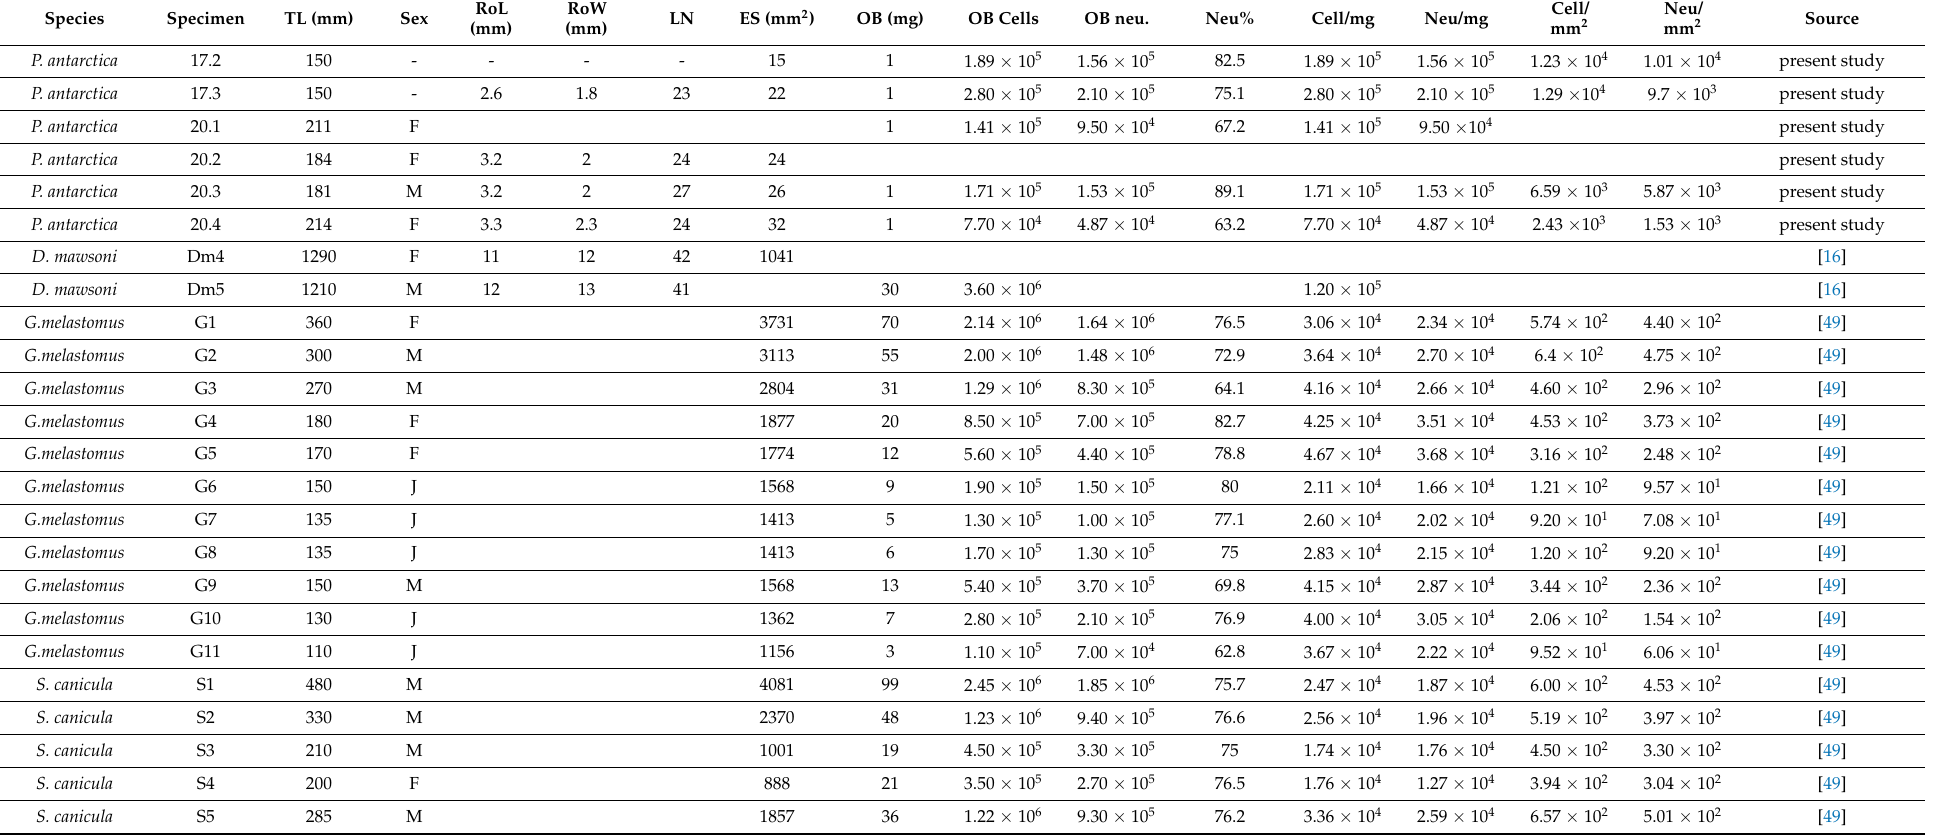
Table 2. Measurements and counts for 4 species of fish from the present study and the literature. TL = the total length was measured for fresh fish for all the specimens but P. antarcticum specimens, where it was calculated on the basis of paraformaldehyde-fixed and ethanol 70%-preserved brains (See Materials and Methods). RoL = Rosette Length; RoW = Rosette Width; LN = lamellar number for one rosette; ES = epithelial surface area for one rosette; OB = mass of the olfactory bulb (one hemisphere); OB cells = number of cells in one OB; OB neu = number of neurons in one OB; Neu% = percentage of neurons in the OB cells; Cell/mg